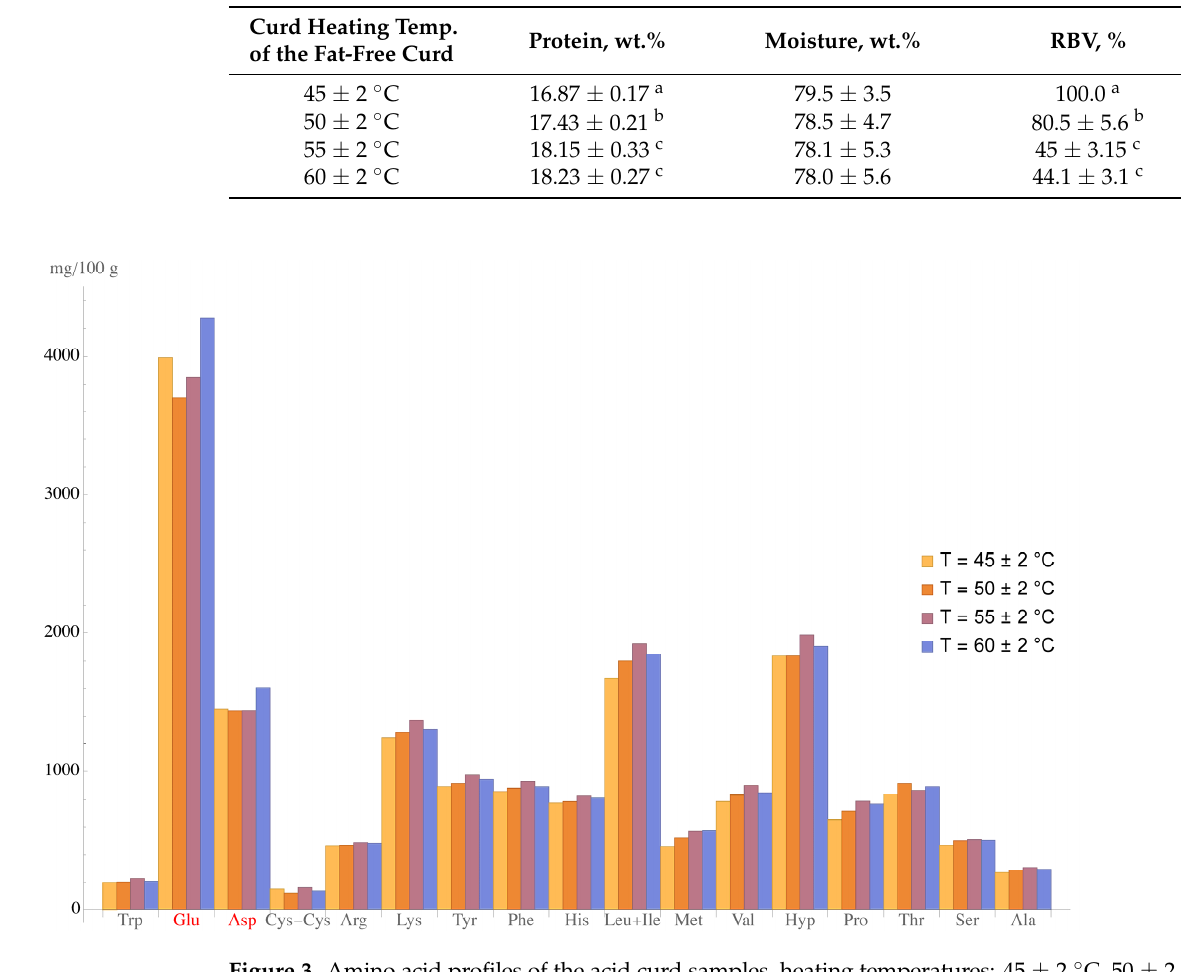
Table 4. Physical, chemical, and biological properties of the acid fat-free curd samples. a–c : Means in columns which do not share the same superscript letter were significantly different.